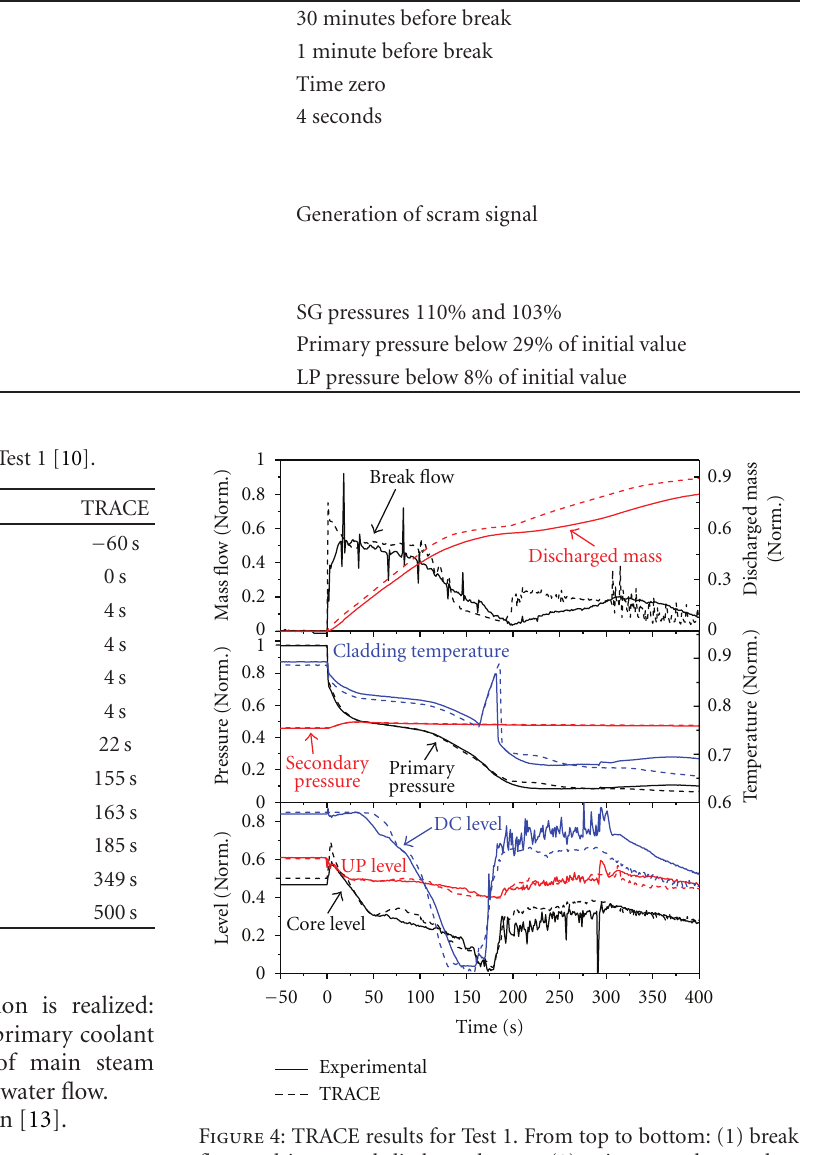
Figure 5: primary and secondary pressures, maximum PCT, break flow and integrated discharged mass, and the RPV collapsed water